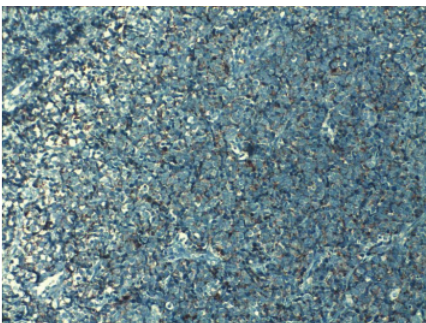
Figure 3: Observed structures, all of which were of tumoral quality. Patchy vascular structures were apparent. Frequent mitotic activities were present. Tumor cells consisted of atypical cells with uniform nuclei and narrow cytoplasm, and some with vesicular nuclei. Immunohistochemical studies showed a positive staining with chromogranin (brown areas).